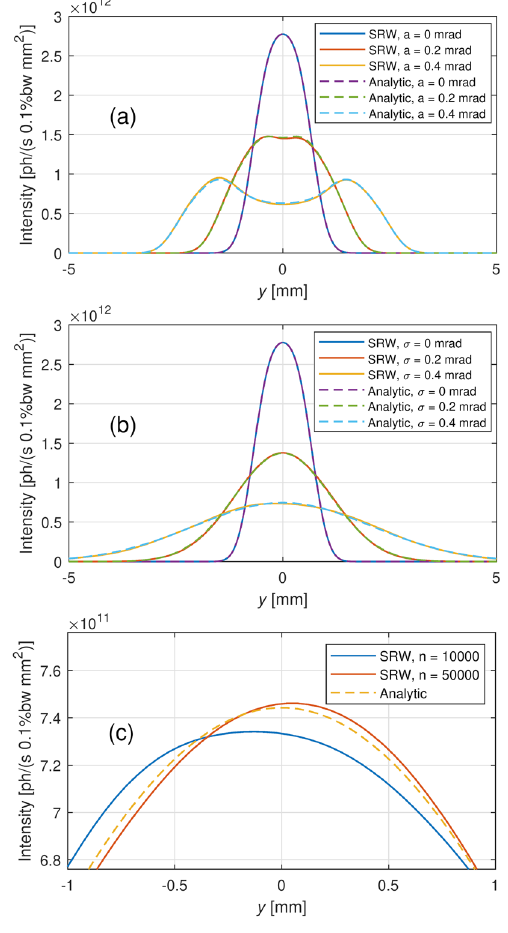
FIG. 4. Simulation and analytical results for vertical cuts of the average intensity distributions at 2.39 keV photon energy for (a) a harmonic noise in the vertical angle (one period of oscillation) with amplitudes of 0,0.2,0.4 mrad; (b) a Gaussian noise with the standard deviations of 0,0.2,0.4 mrad; and (c) comparison of the simulation results from 10,000 and 50,000 initial conditions with the analytical result of the Gaussian noise with σ ¼ 0 . 4 mrad. The magnetic field and beam parameters are the same as those used in the calculations illustrated in Fig.